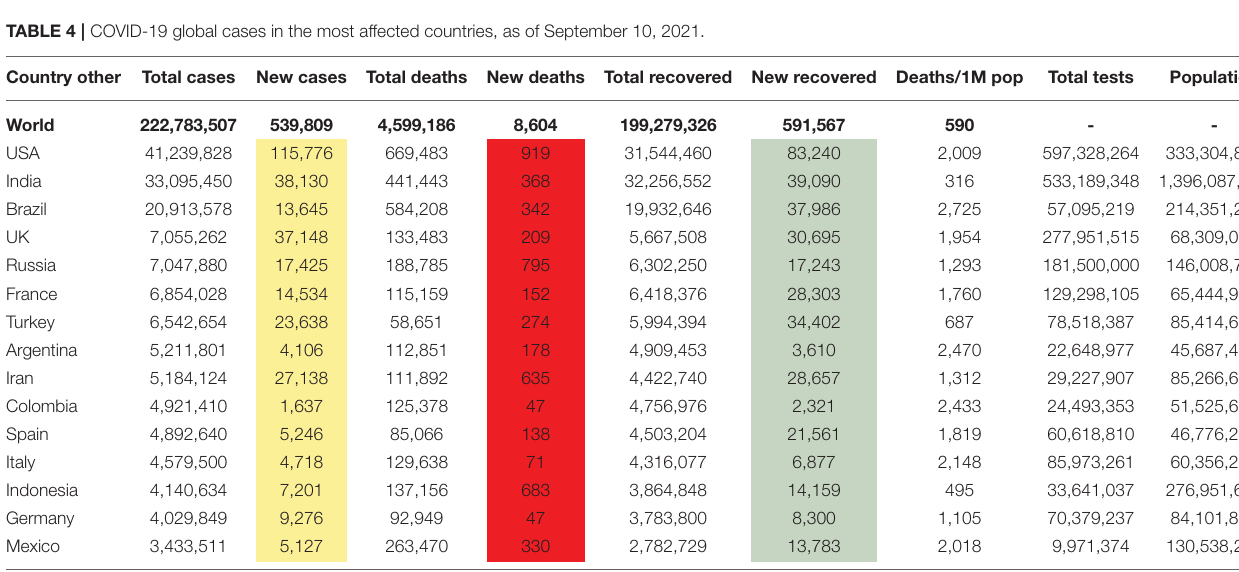
Source: WHO and JHU CSSE COVID-19 Data. Yellow highlight shows new cases, red highlight new deaths, and green highlight specifies new recovered cases in selected countries.